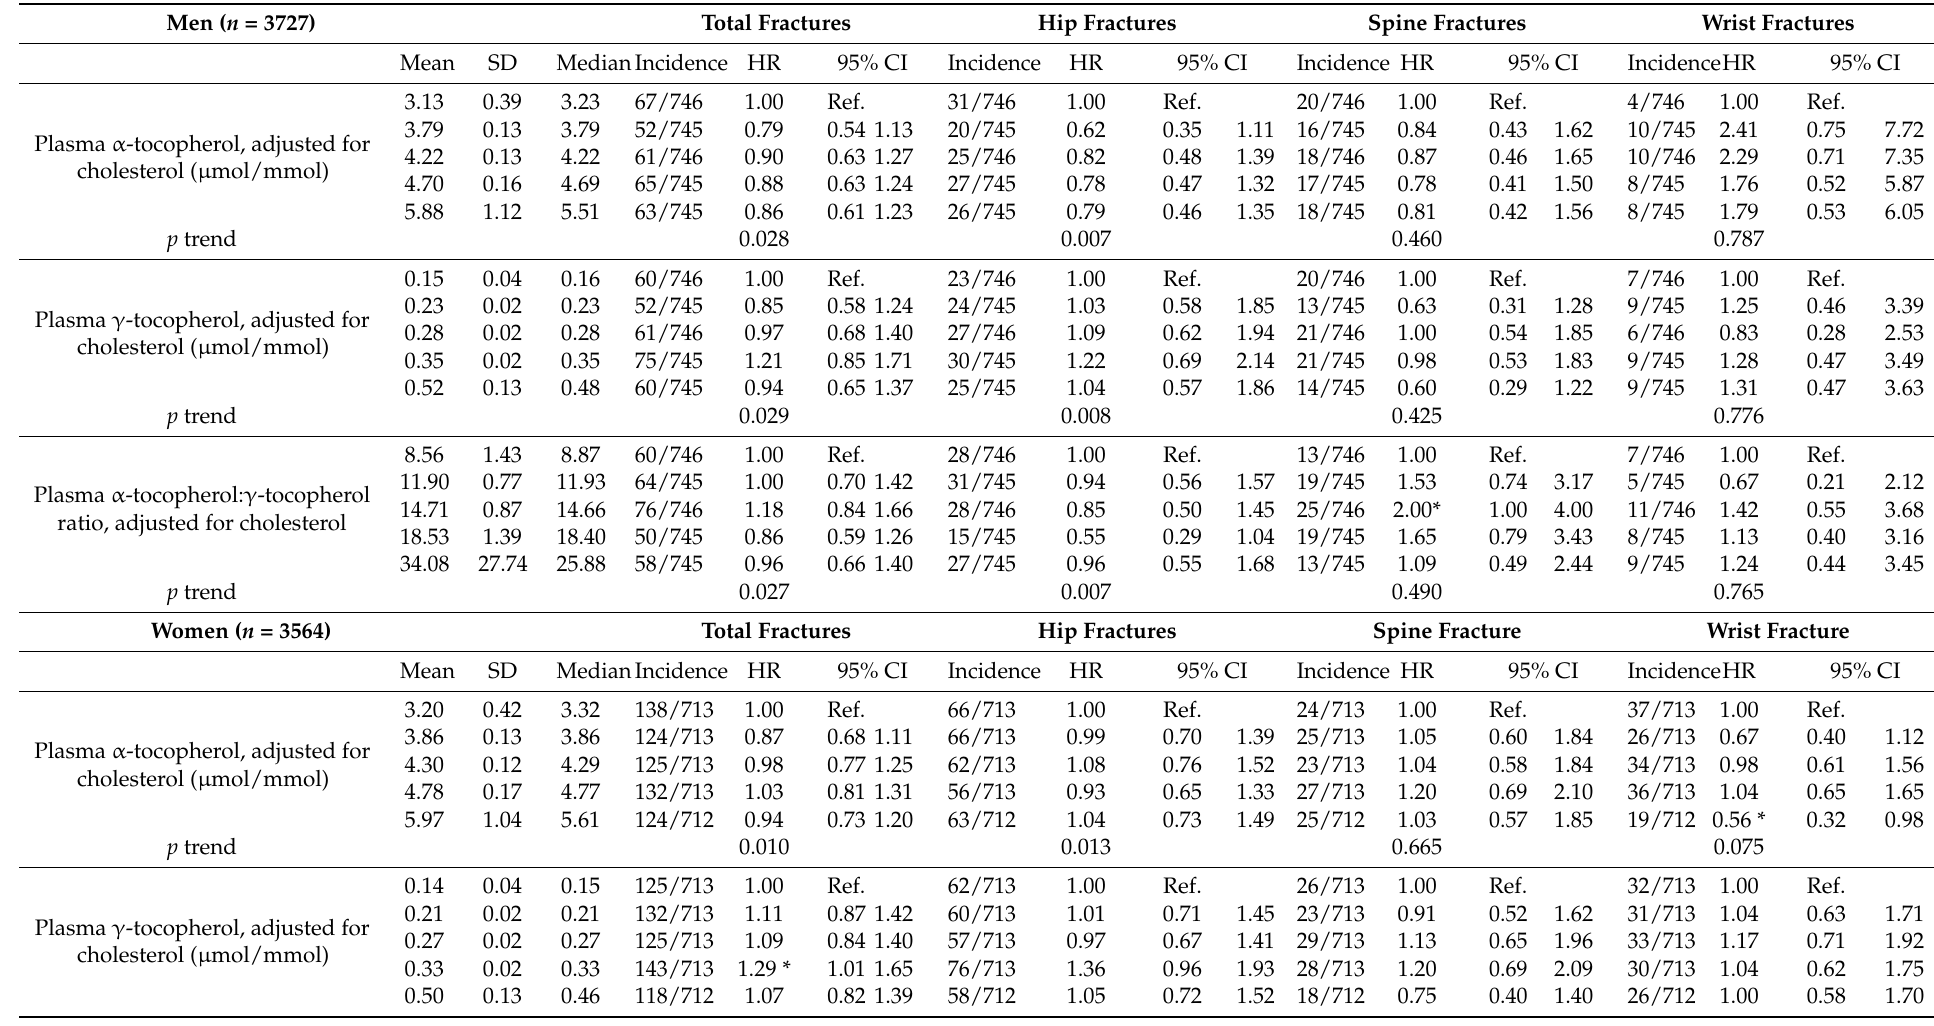
Table 8. Risk of total, hip, spine and wrist fractures in EPIC-Norfolk participants, stratified by sex and quintiles of plasma α -tocopherol, plasma γ -tocopherol and the ratio of α : γ , adjusted for cholesterol.